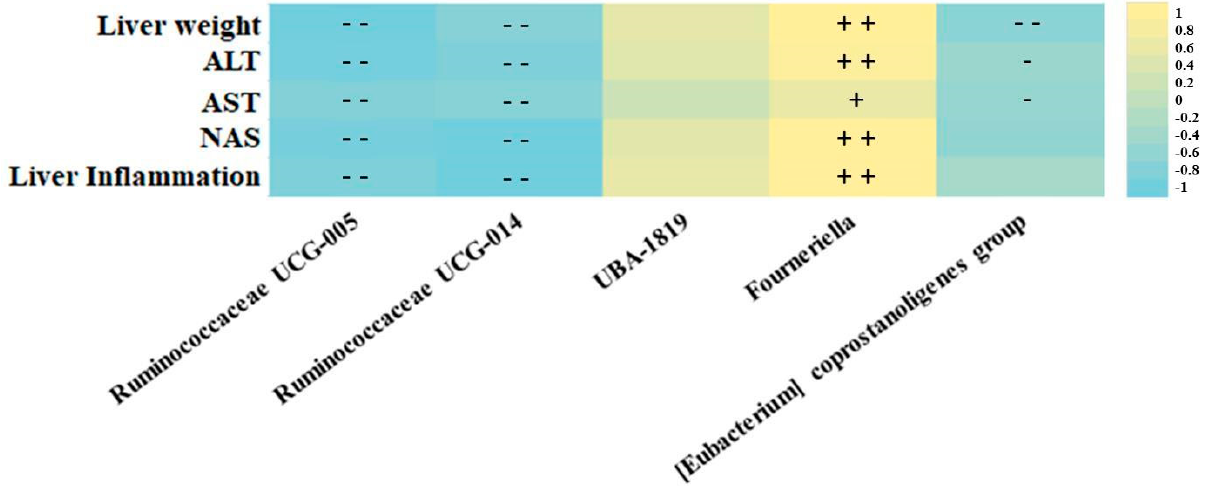
Figure 3. Representative heatmap of the Spearman correlation values of the most abundant Ruminococcaceae family microbes and studied liver damage markers. +/ − = p < 0.05, ++/ − − = p < 0.01.